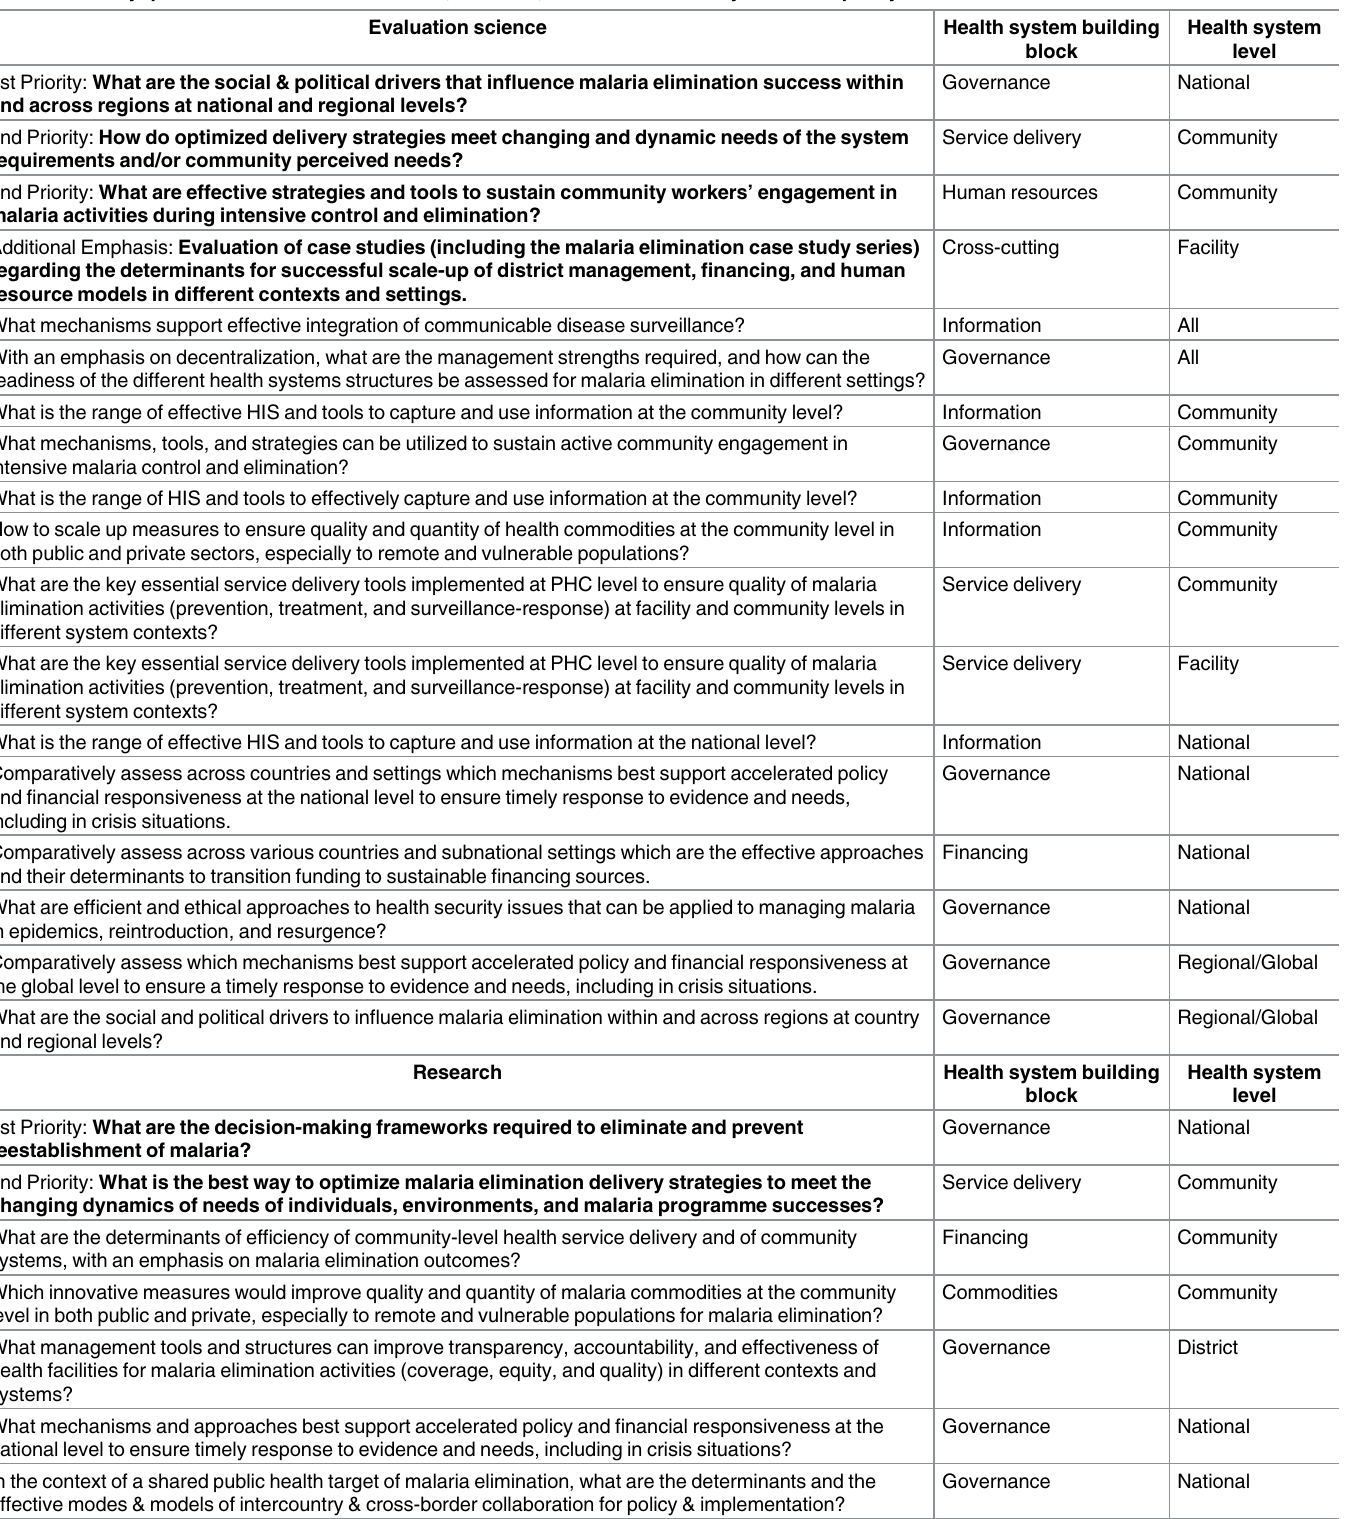
Table 1. Priority questions for evaluation science, research, and R&D in health systemsand policy